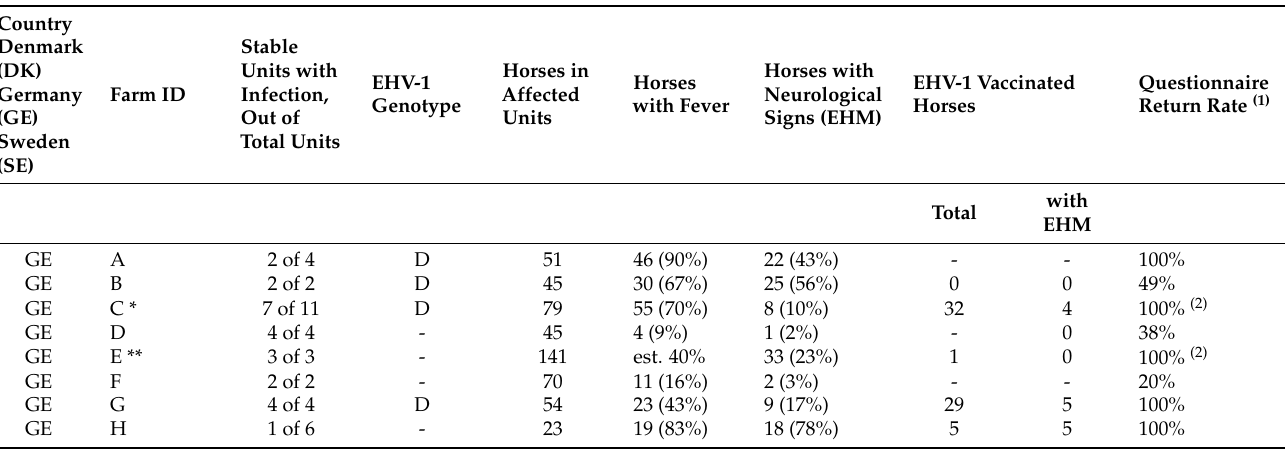
Table 2. EHV-1 outbreak characteristics of included